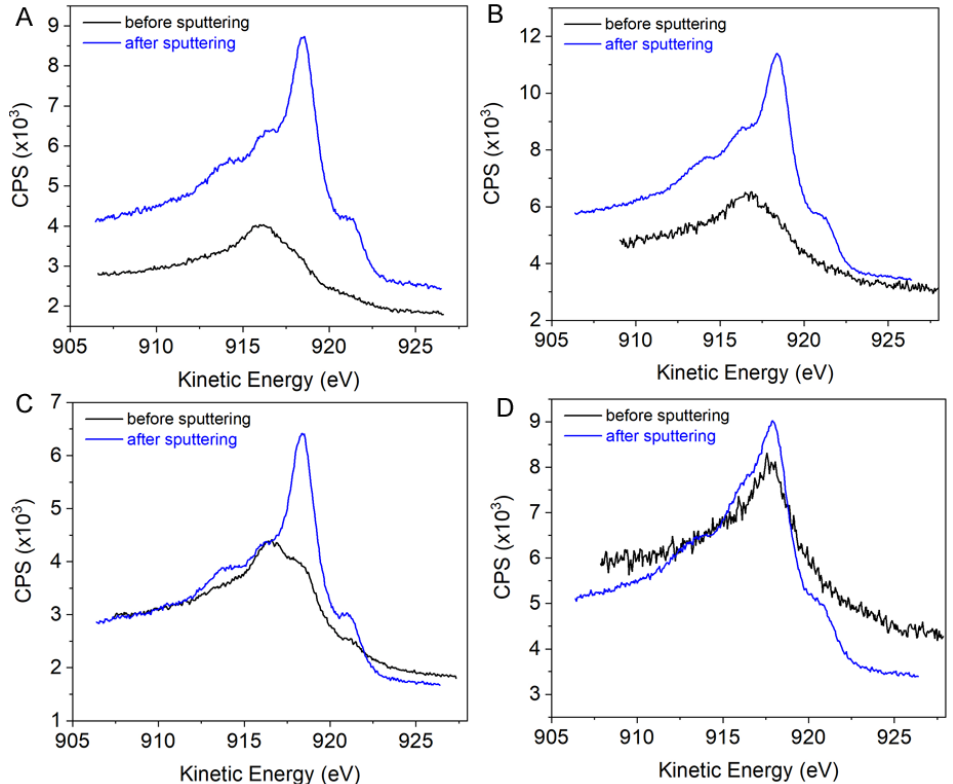
Figure 5. Cu LMM spectra of the PEG-SH coated CuNPs: ( A ) suspended in water freshly prepared; ( B ) suspended in water for 5 days; ( C ) suspended in ethanol freshly prepared; ( D ) suspended in ethanol after 5 days. The black curves are the spectra of the pristine samples while the blue curves are the corresponding samples treated with 10 min of Ar sputtering to remove a few monolayers of atoms from the surface.